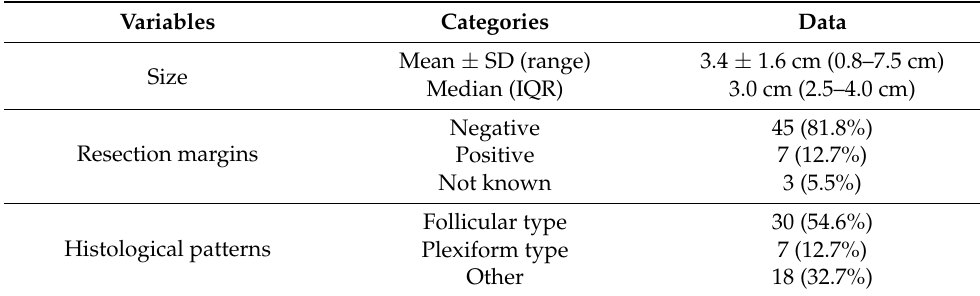
Table 3. Size, resection margins, and histological patterns of the ameloblastomas.